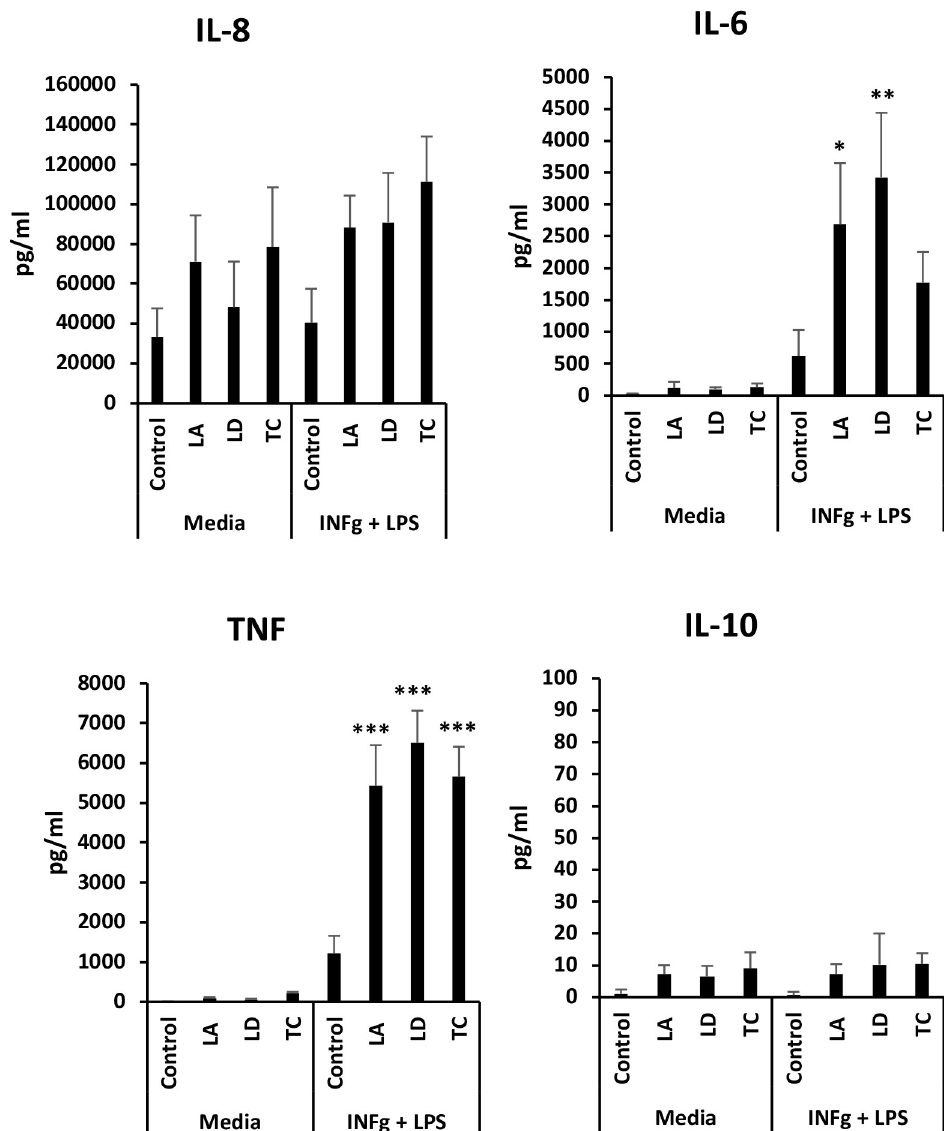
Fig 3. Infection of macrophages with L . amazonensis , L . donovani or T . cruzi does not induce inflammatory cytokine secretion by resting macrophages. Culture media of macrophages infected with L . amazonensis (LA), L